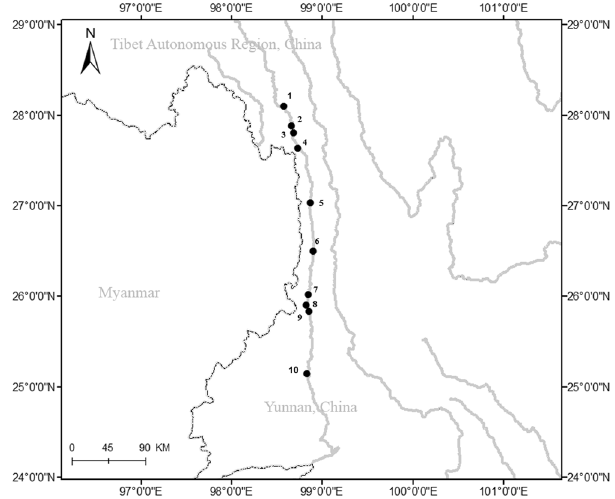
Figure 1. Map showing locations of the 10 sites where C. macropterus samples were collected. 1–10 are the codes of Qiunatong, Geza, Changwa, Xiyuegu, Lumadeng, Pihe, Delongba, Degeng, Liuku, and Mangliu, respectively. Of this, 1–4 are codes of up-tributaries, 5 and 10 are codes of mid-tributary and low-tributary, and 6–9 are codes of main stem. Map was created in the ArcGIS version 10.1 and modified in Microsoft